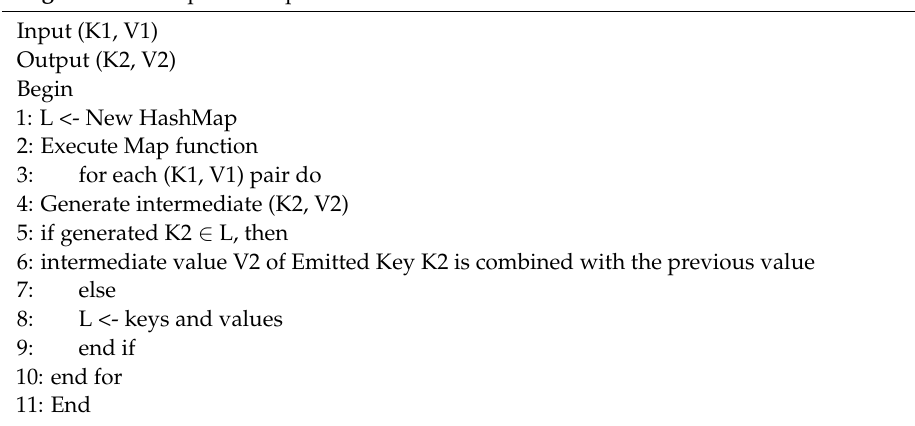
Figure 3. Proposed IMapC in TFR. Algorithm 1 : Proposed Map function